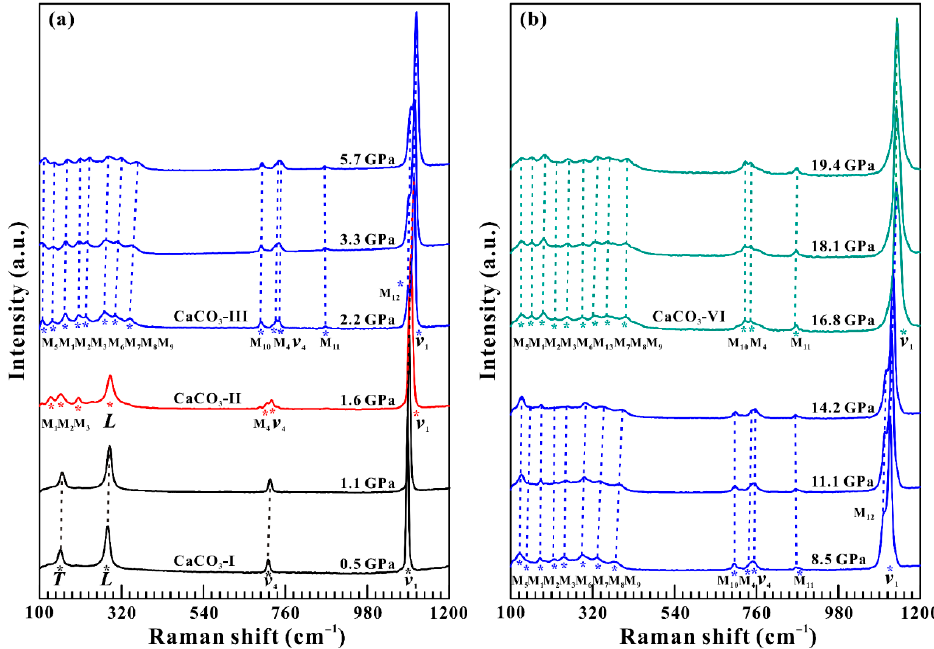
Figure 2. Raman scattering spectra of calcite at different pressure points up to 19.4 GPa upon compression at the atmospheric temperature. ( a ) 0.5–5.7 GPa; ( b ) 8.5–19.4 GPa. The red, blue, and green asterisks denote the positions of the Raman peaks of high-pressure CaCO 3 polymorphs. The colored dashed lines are used to guide the eyes.